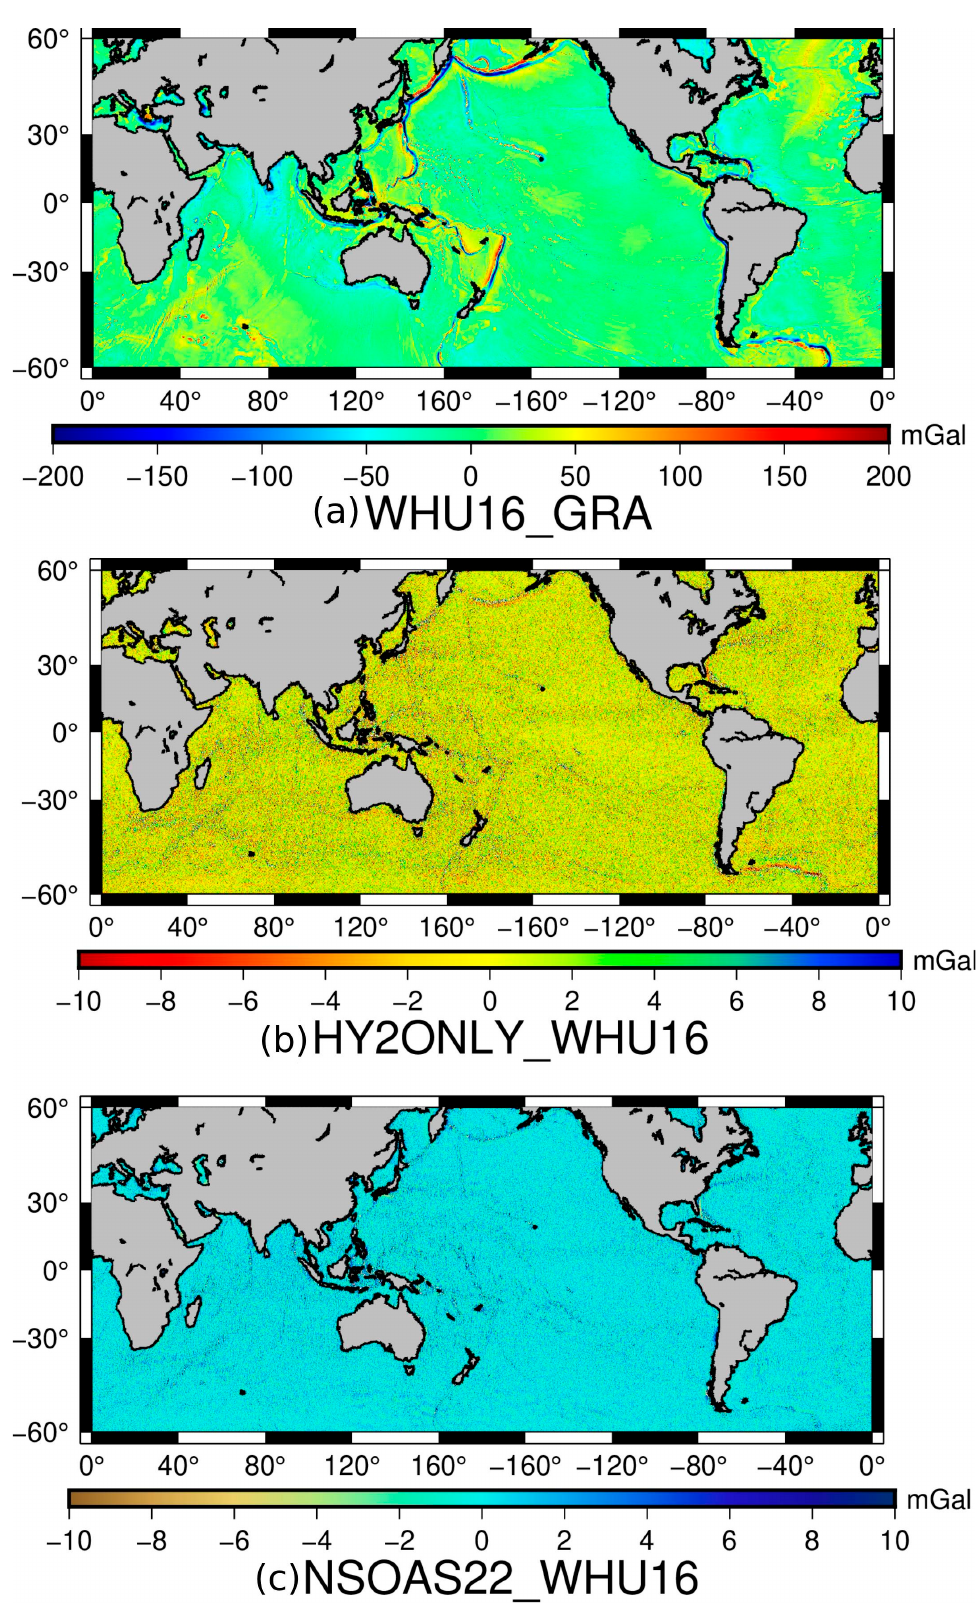
Figure 3. Gravity anomaly: ( a ) WHU16_GRA; ( b ) The difference between HY2ONLY_GRA and WHU16_GRA; and ( c ) The difference between NSOAS22_GRA and WHU16_GRA.